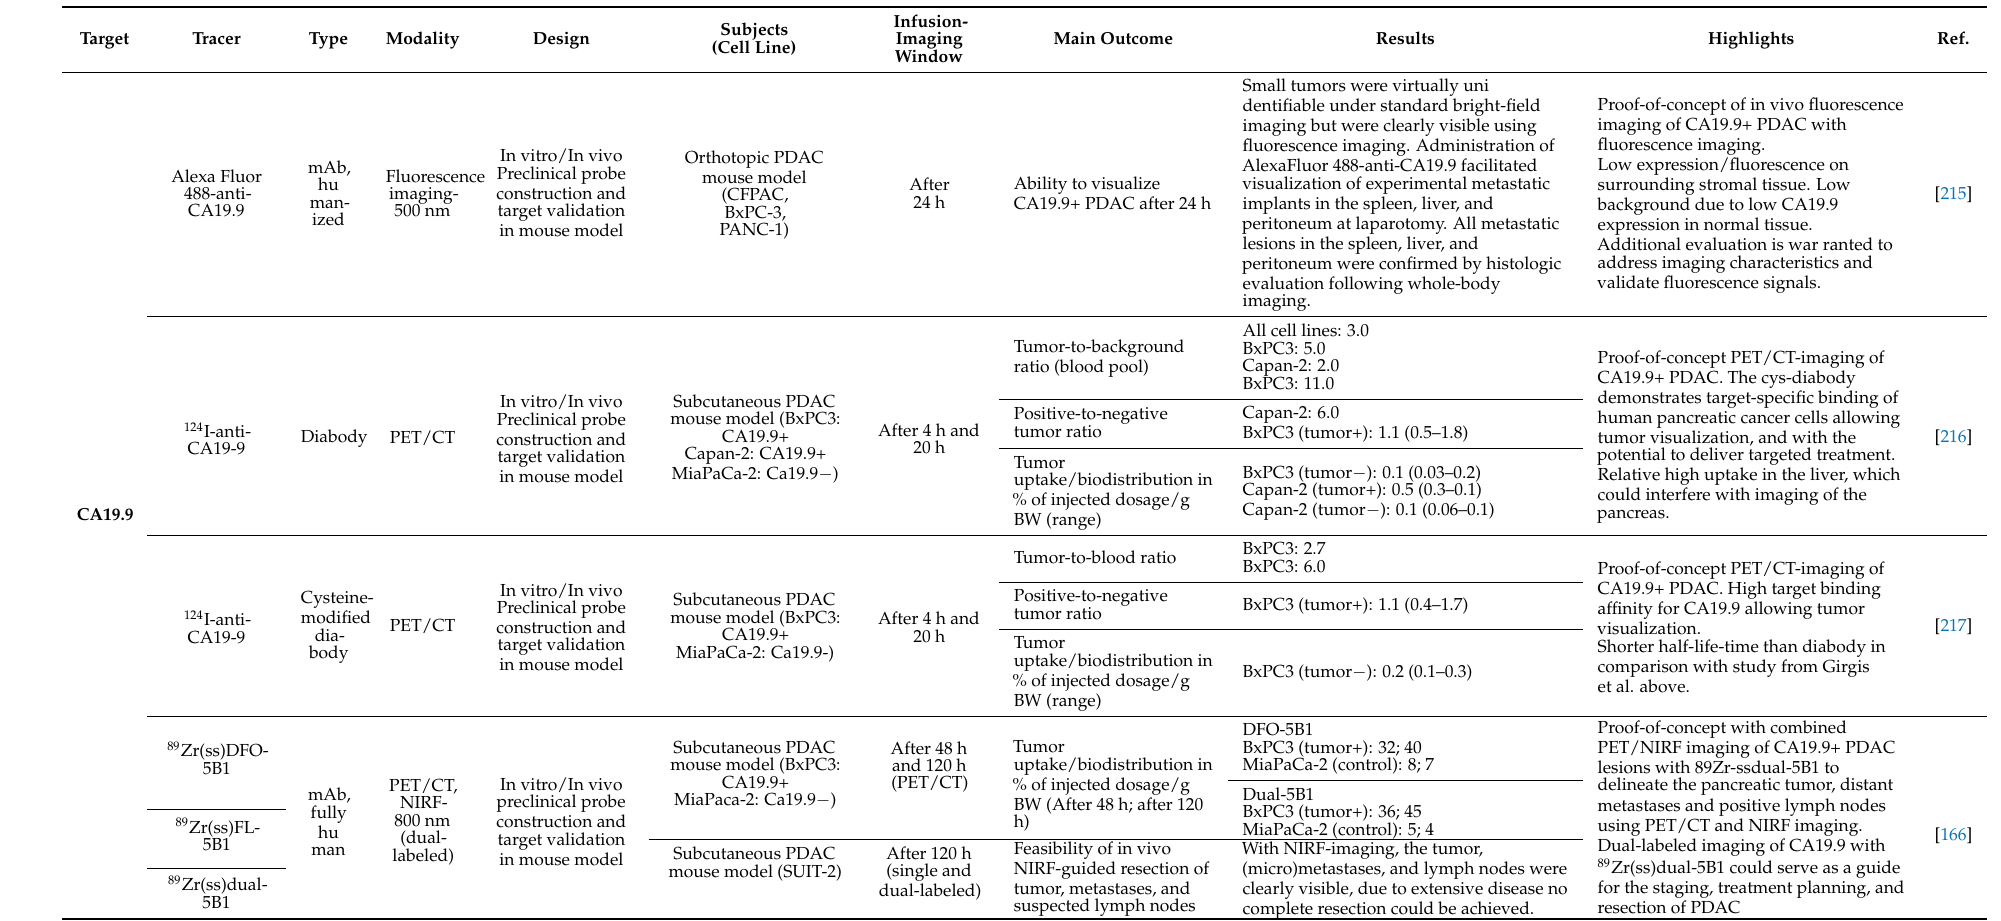
Table A2. Pre-clinical studies evaluating targeted molecular imaging (PET/CT—fluorescence Imaging) of